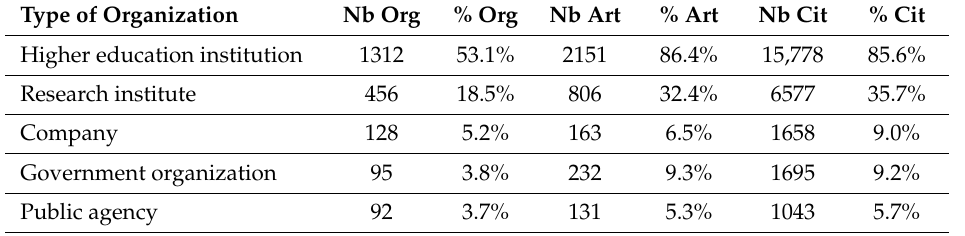
Table 7. Number and share of articles and citations per type of organization ( n = 2100).